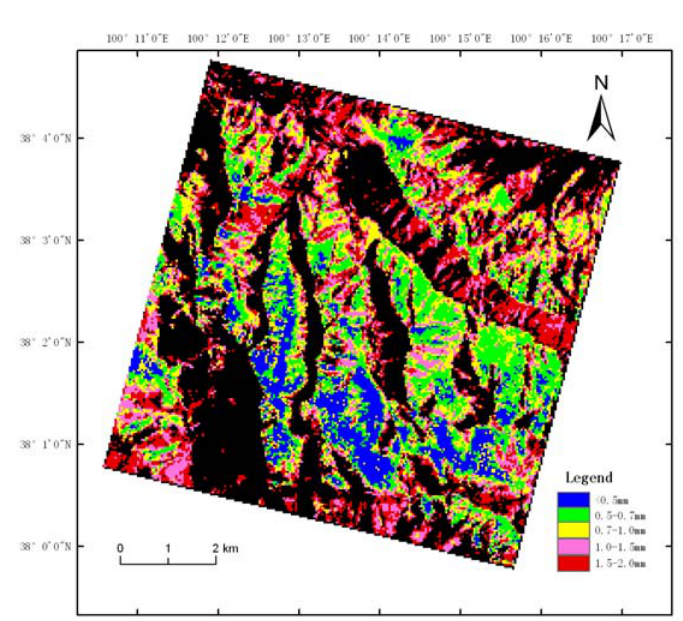
Figure 14. New distribution of the snow grain